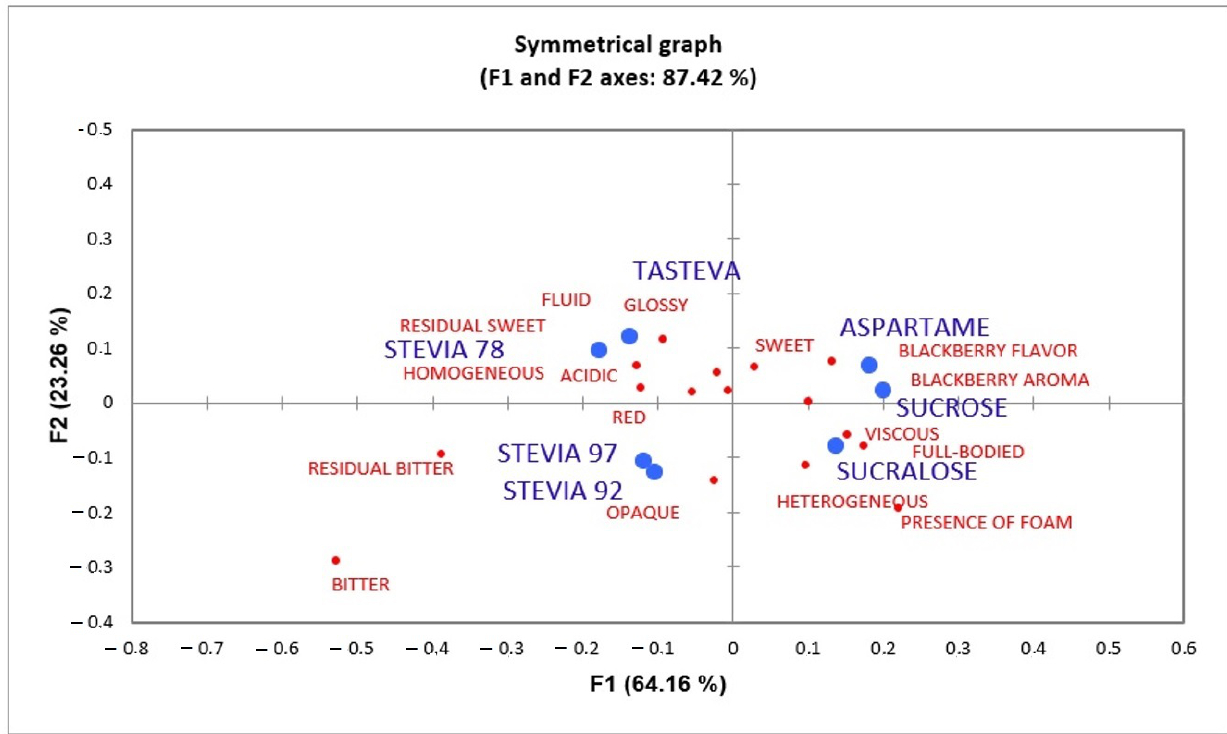
Figure 6. Correspondence analysis of “check-all-that-apply” (CATA) words. Red dots are words used in the CATA and blue dots are the sweeteners applied in the blackberry